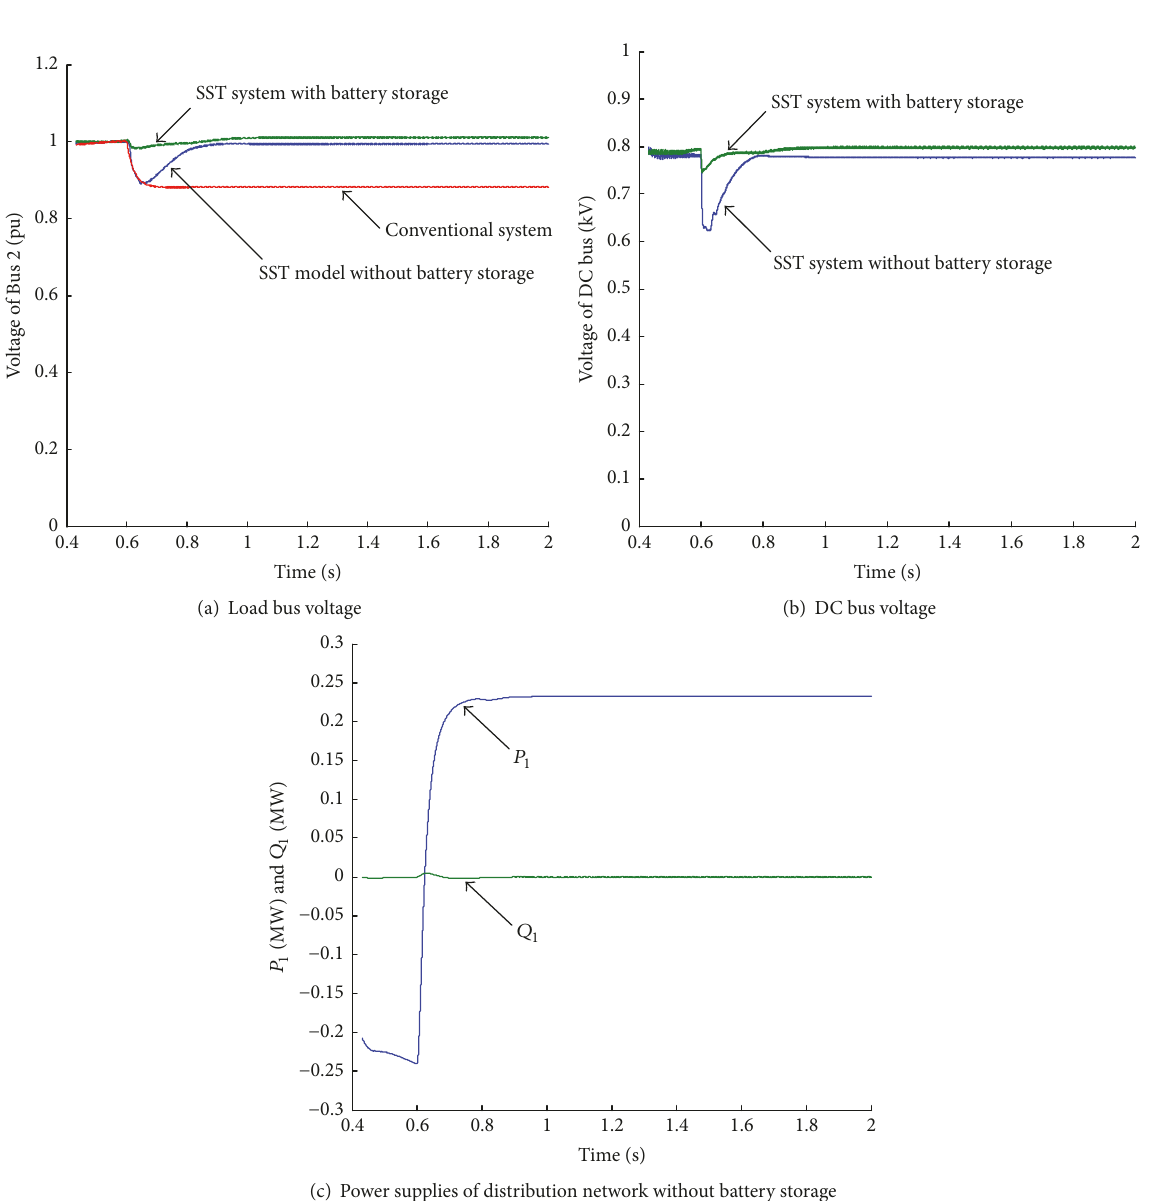
Figure 9: Response curves when total output of DGs drops to